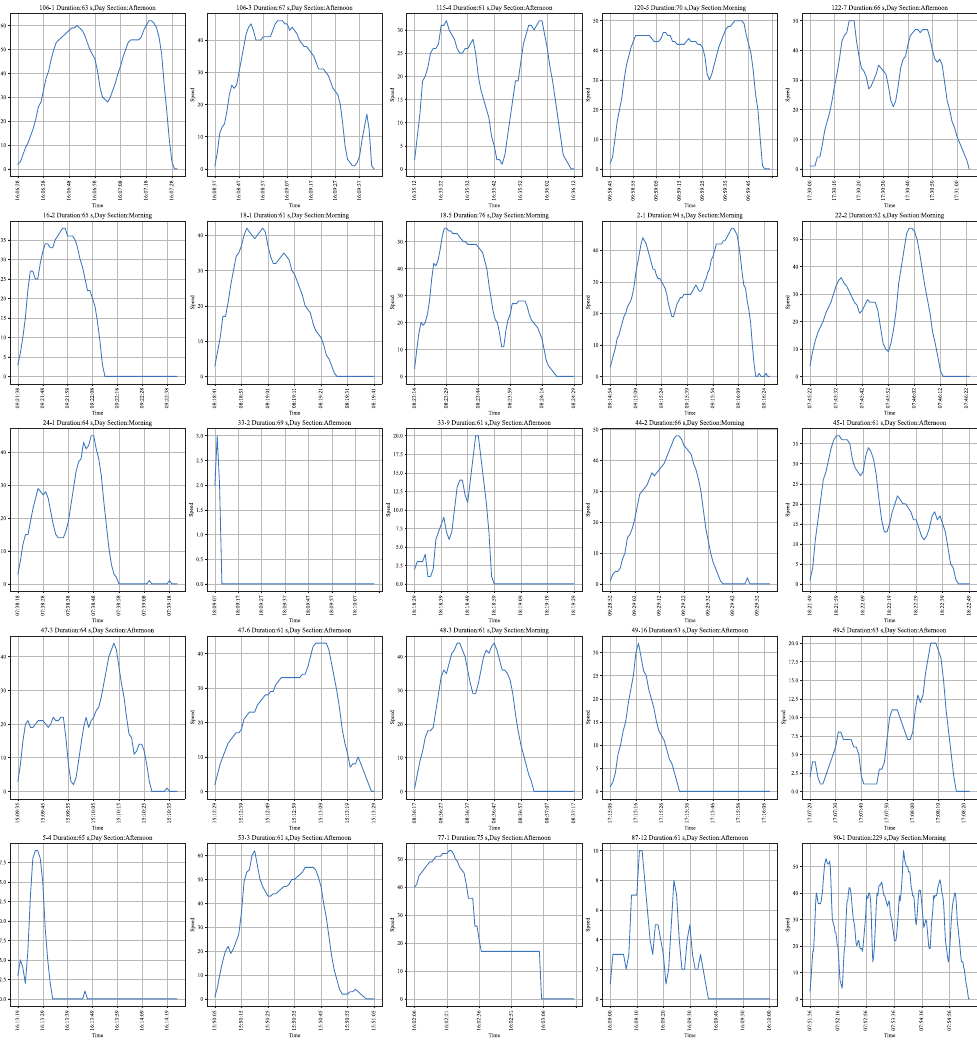
Figure 15. Micro-trips for the candidate driving